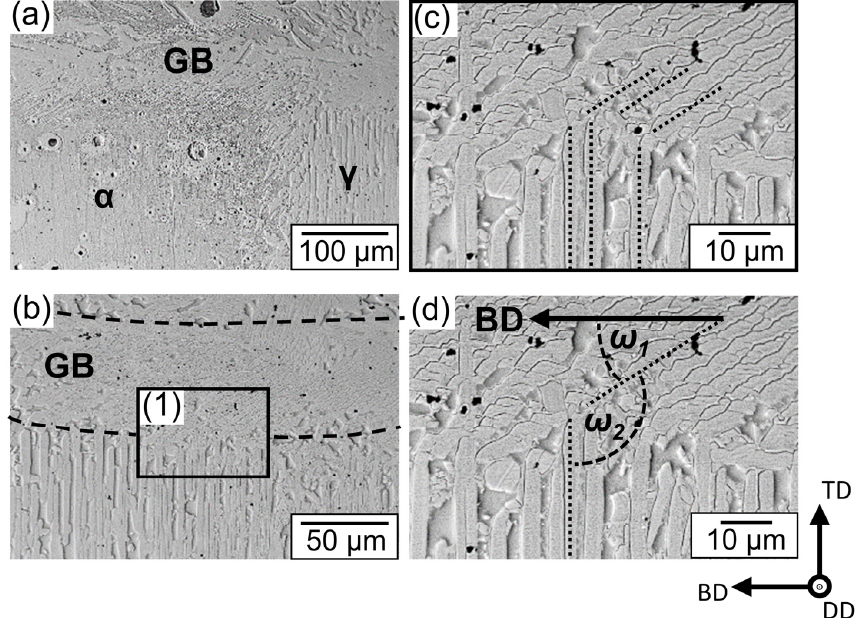
Figure 5. SEM image of the polished and etched BD-TD section; ( a ) showing an overview of the transition to the HAZ and an adjacent grain boundary (GB); ( b ) interface between the primarily formed γ grains along the grain boundary and the secondarily formed γ grains in the grain interior; ( c ) higher magnification detail of ( 1 ) showing the interface between primarily and secondarily γ grains; ( d ) angles between the primarily γ grains (dashed lines indicate the orientation of the major axis) and the BD ( ω 1 ) and between the primarily and secondarily γ grains ( ω 2 ) are dotted; the sample coordinate system is defined by the building direction (BD), deposition direction (DD) and transverse direction (TD).